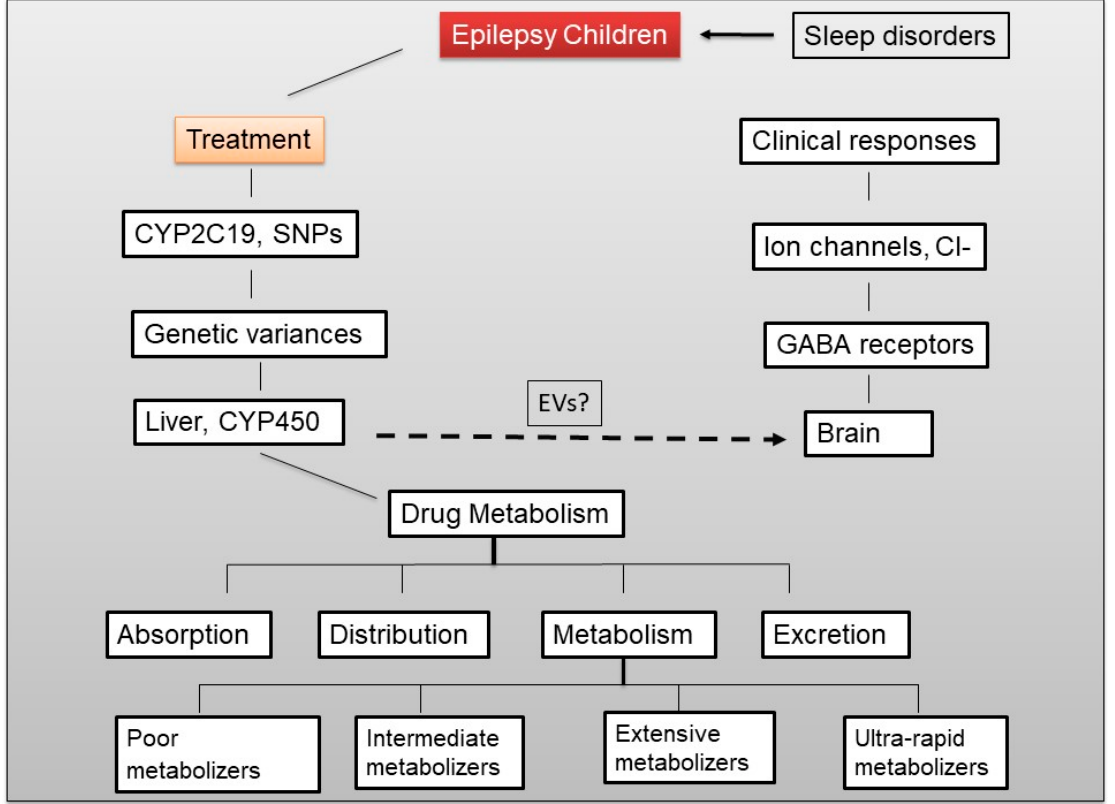
Figure 1. Diagram illustrates the effects of sleep disorders and epilepsy treatment on γ -aminobutyric acid (GABA) receptors (A, B & C), CYP2C19 gene and drug metabolism.